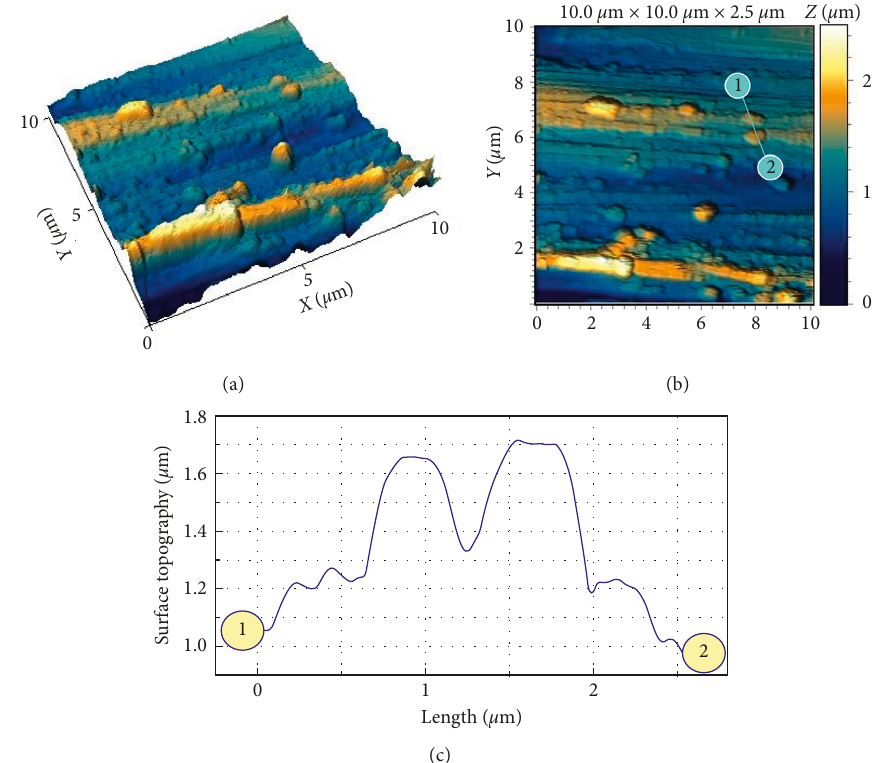
Figure 8: 3D (a) and 2D maps (b) of the surface and cross-sectional profile between markers 1 and 2 (c) for Ti │ TiO 1.5A/dm 2 , U 60 V, t 25 ° C. Scanning area AFM 10 1M K 4 P 2 O 7 , i (cid:29) (cid:29) (cid:29)